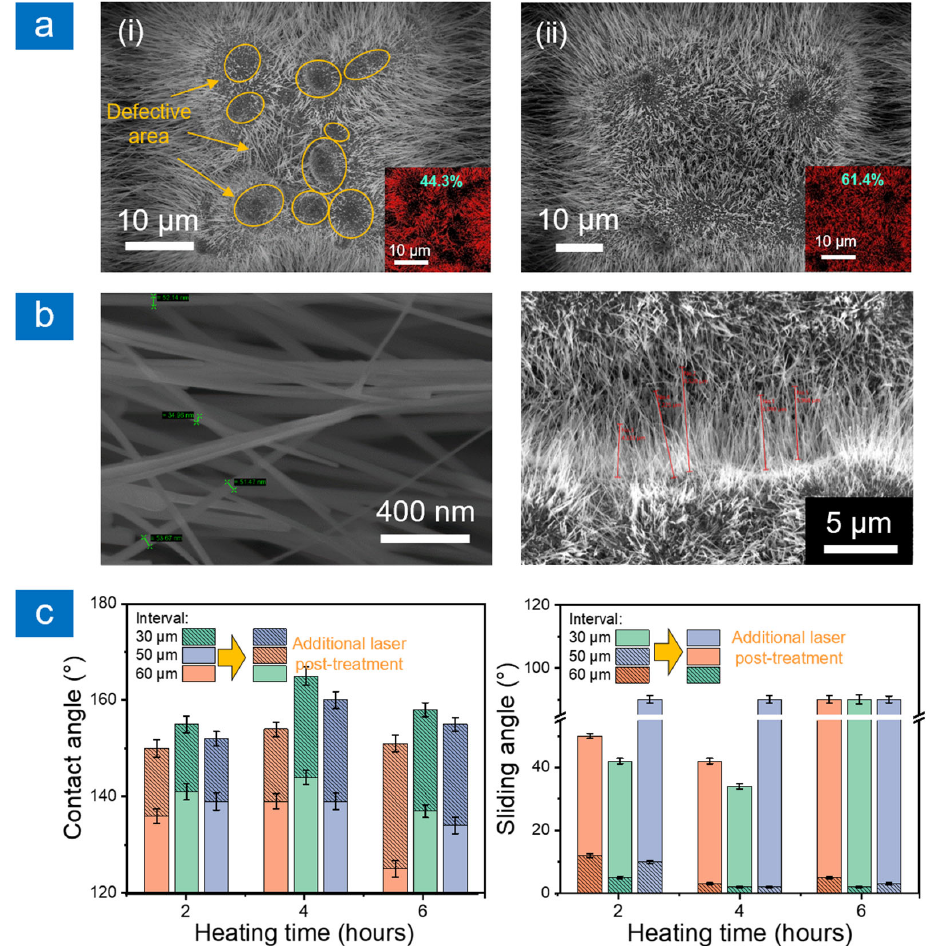
Figure 2. ( a ) SEM images of surface morphology by laser texturing and thermal oxidation ( i ) without and ( ii ) with laser post-treatment. ( b ) Diameter and length of CuO nanowires of 50LT–LPT–4TO sample. ( c ) Comparison of surface wettability: contact angles on the left chart and sliding angles on the right chart.